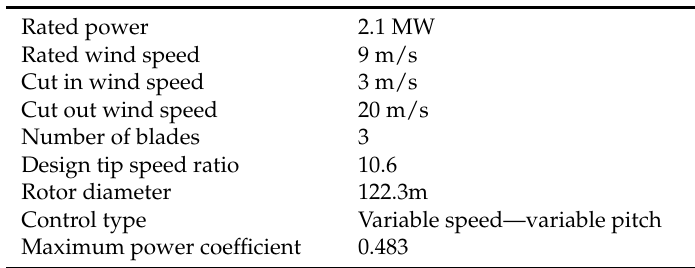
Table 2. Wind turbine characteristics.